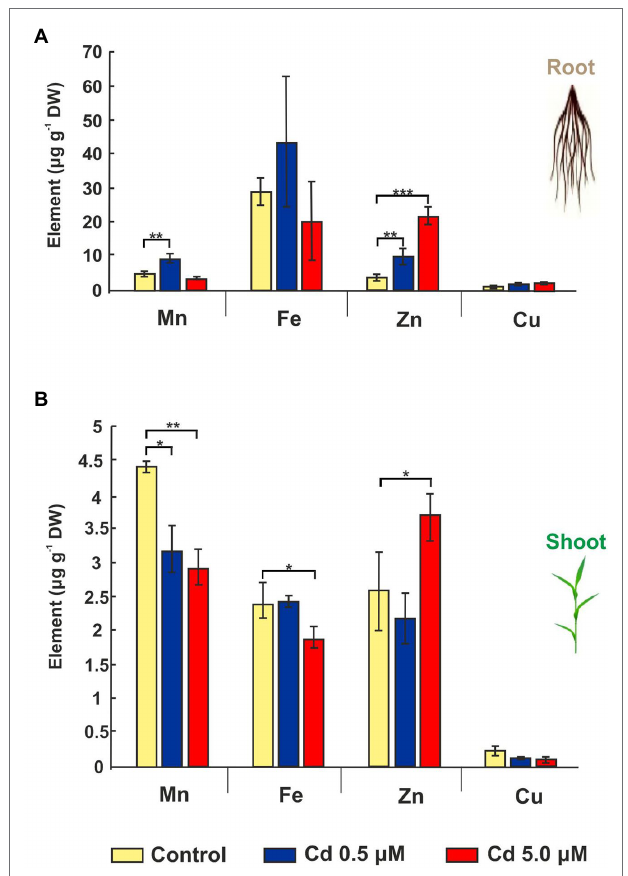
FIGURE 4 | Mineral elements in roots and shoots of wheat seedlings grown for 15 days (starting from sprouting) in control conditions and in presence of Cd 0.5 and 5.0 μ M. Panel (A) Mn, Fe, Zn, and Cu concentrations expressed as μ g/g DW of root. Panel (B) Mn, Fe, Zn, and Cu concentrations as μ g/g DW of shoot. T -test p < 0.05*, <0.01**, and